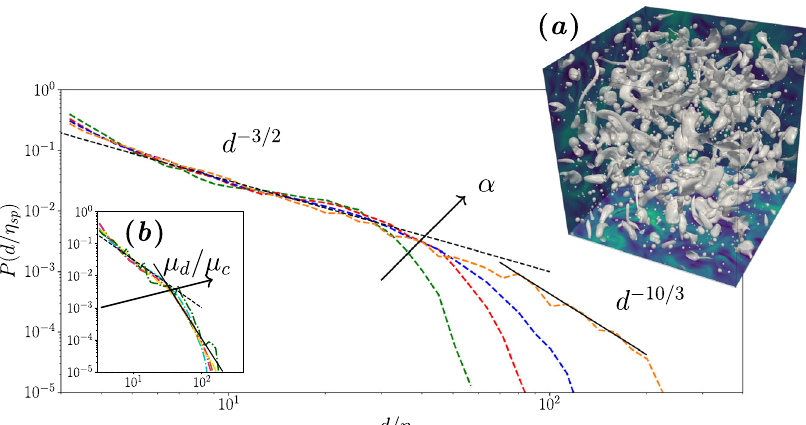
Fig. 1 The droplet-size-distribution of emulsions in homogeneous and isotropic turbulence. Droplet-size-distribution for emulsions in homogeneous and isotropic turbulence at different volume fractions α , i.e., 0.03 (green dashed line) 0.06 (red dashed line) 0.1 (blue dashed line) 0.5 (ocher dashed line) at constant large-scale Weber number (see Methods) We L ¼ 42 : 6 and μ d / μ c = 1. The droplet diameter is normalized with the Kolmogorov scale η sp for the single-phase reference case (also used as initial condition for all simulations) at Re λ = 137. Similarly, inset ( b ) shows the DSD different viscosity ratio μ d / μ c , i.e., 0.01 (black dot-dashed line) 0.1 (red dot-dashed line) 1 (cyan dot-dashed line) 10 (yellow dot-dashed line) 100 (dark green dot-dashed line), at constant α = 0.1 and We L ¼ 42 : 6. The black dashed line indicates the − 3/2 power-law and the continuous black line the − 10/3 power-law. Inset ( a ) shows a render of the simulation at We L ¼ 42 : 6, α = 0.1 and μ d / μ c = 1. The droplets diameter is considered to be the volumetric one, i.e., d ¼ ð 6 V d = π Þ 1 = 3 , with V d the droplet